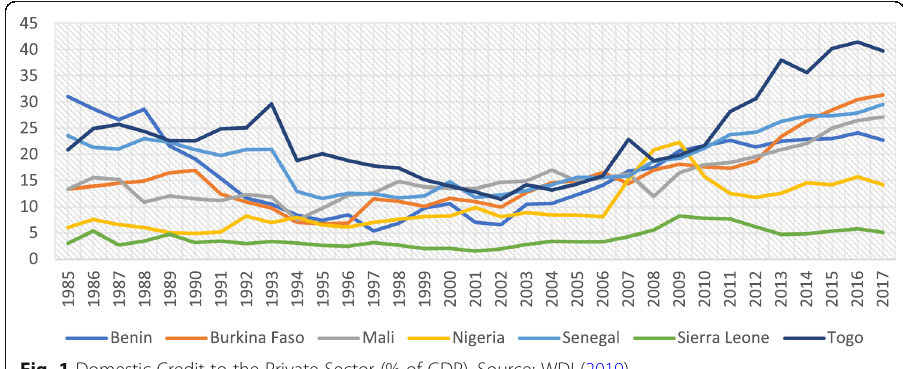
Fig. 1 Domestic Credit to the Private Sector (% of GDP). Source: WDI